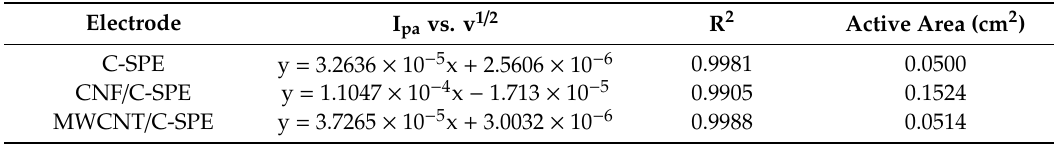
Table 3. I pa vs. v 1 / 2 linear regression equations, determination coe ffi cients and active surface areas of all the screen-printed electrodes